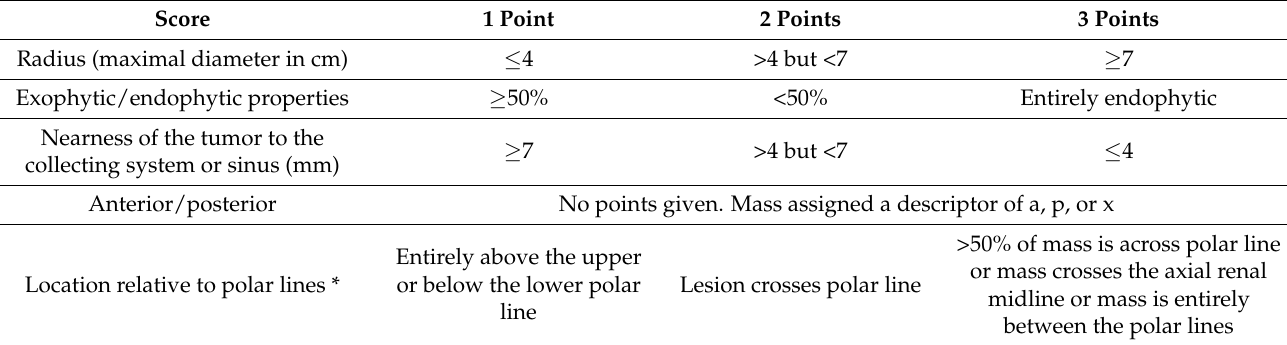
Table A2. R.E.N.A.L. Nephrometry score with scoring of location component, as published by Kutikov et al. [39]. Score 1 Point 2 Points 3 Points Radius (maximal diameter in cm) ≤ 4 >4 but